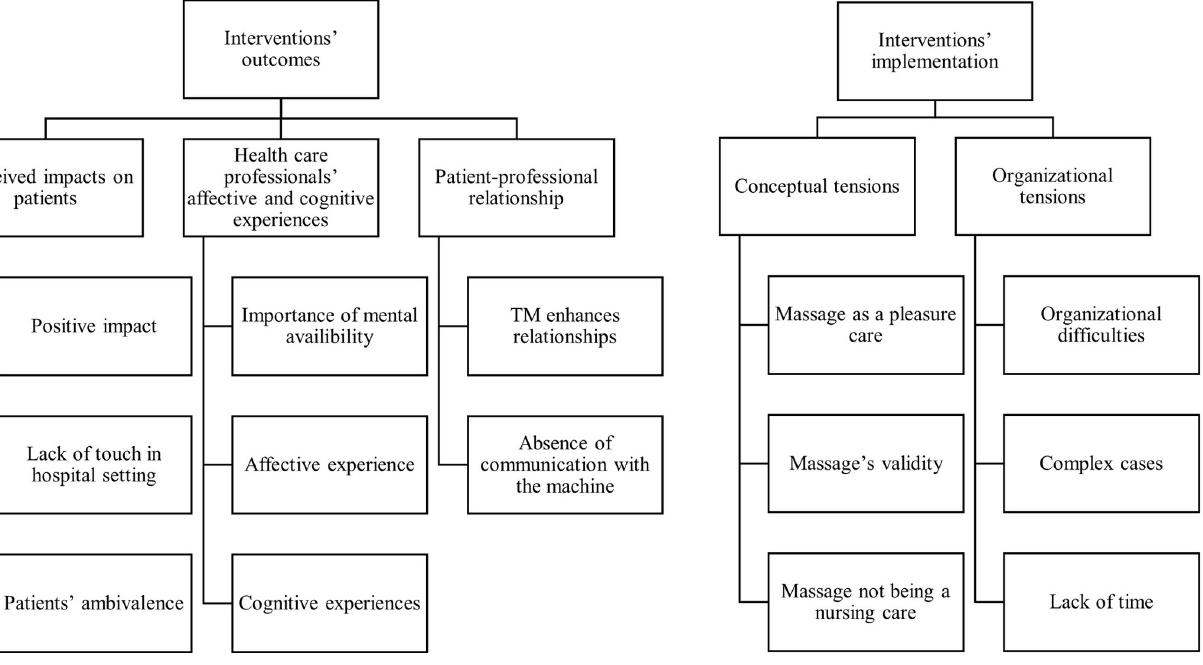
PLOS ONE | https://doi.org/10.1371/journal.pone.0281078 February 27,